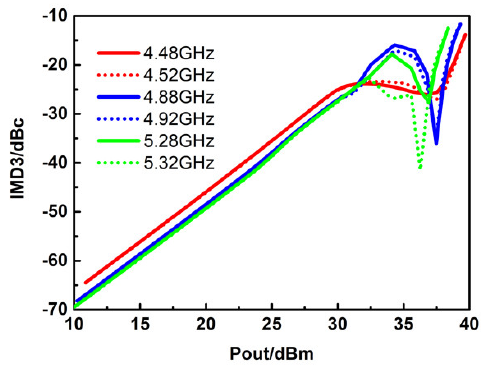
Figure 14. IMD3 of DPA at the center frequency of 4.9 GHz.